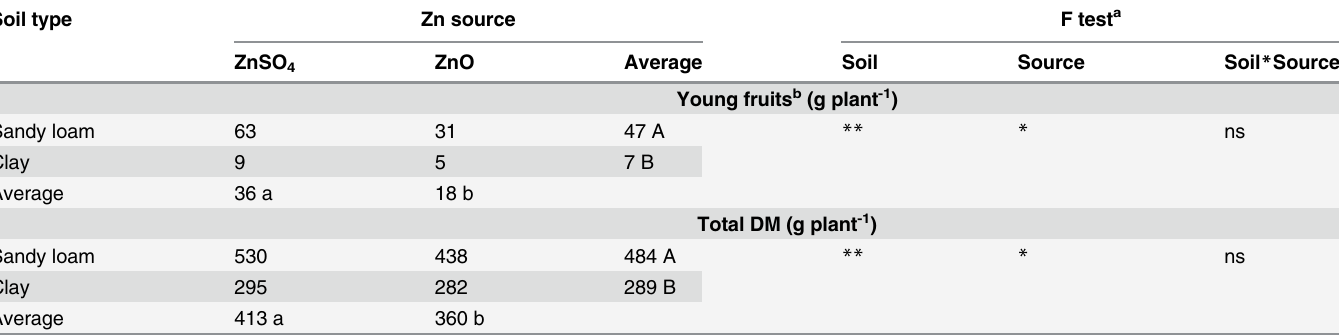
Table 2. Dry mass (DM) of plant parts of young orange trees 150 days after ZnSO 4 and ZnO application in soils with sandy loam or clay texture. Soil